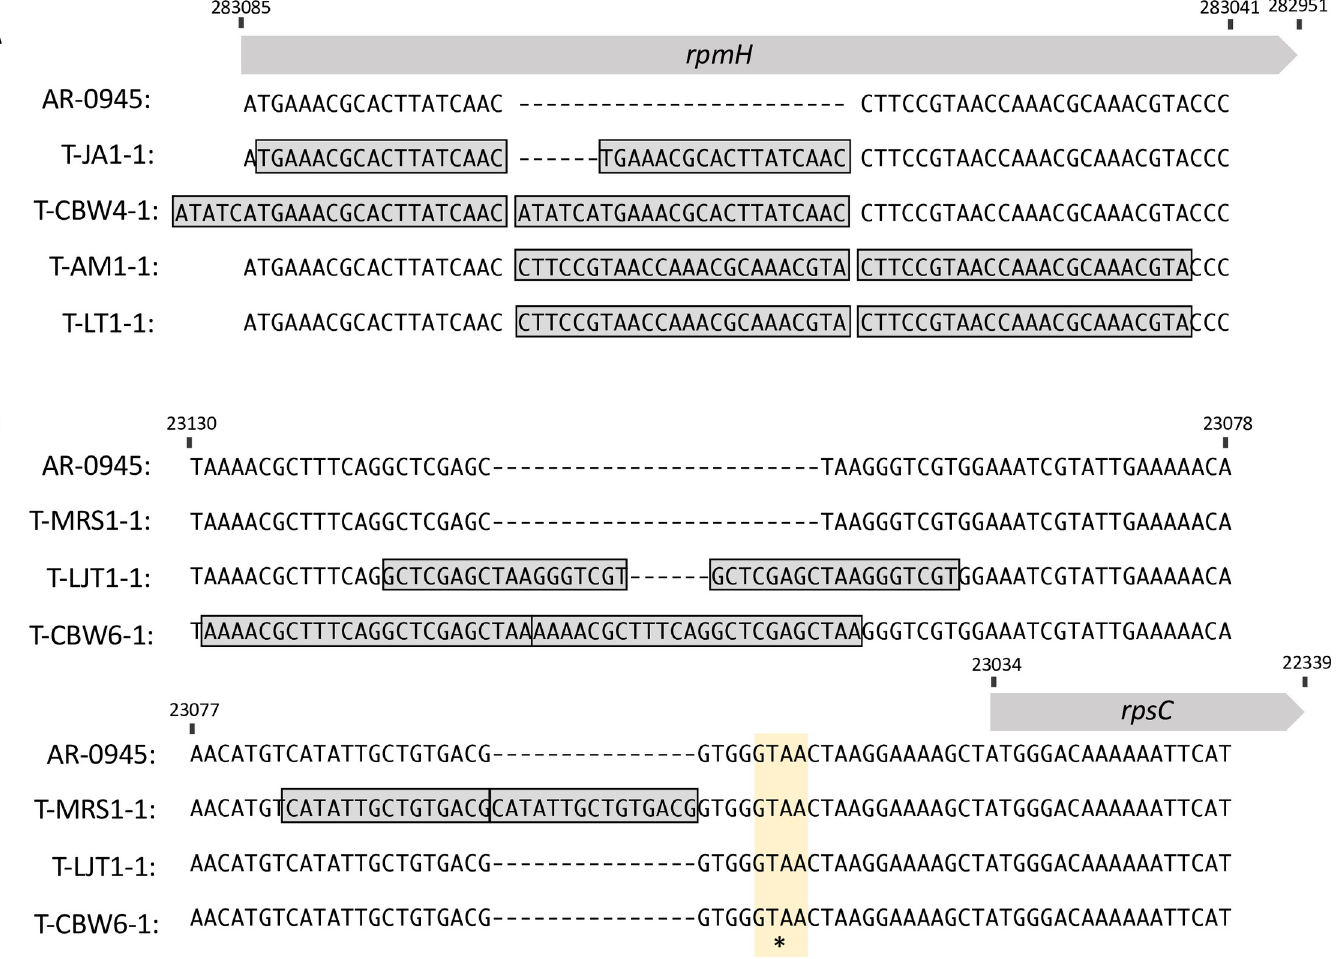
Fig 2. Repeated emergence of mutations within and proximal to genes encoding ribosomal proteins are causal to high-level azithromycin resistance. (A) Whole genomic sequencing revealed that four strains evolved duplications in rpmH , the gene encoding the 50S ribosomal protein L34. Transformants (T-AM1, T-CBW4, T-JA1, and T-LT1) generated from these lineages were Sanger sequenced to confirm the location and identity of nominated derived insertional polymorphisms, data shown. (B) The remaining mutations underlying high-level resistance (n = 3) were located proximally to rpsC , which encodes the 30S ribosomal protein S3, and were also duplication events. Sanger sequences for the transformants (T-CBW6, T-LJT1, and T-MRS1) are displayed. Reference positions in Node 1 and Node 4 of the AR-0945 draft assembly are displayed for rpmH and rpsC respectively. The highlighted GTAA region is duplicated in the 3 of 18 Nel genomes deposited on NCBI (S1 Table).